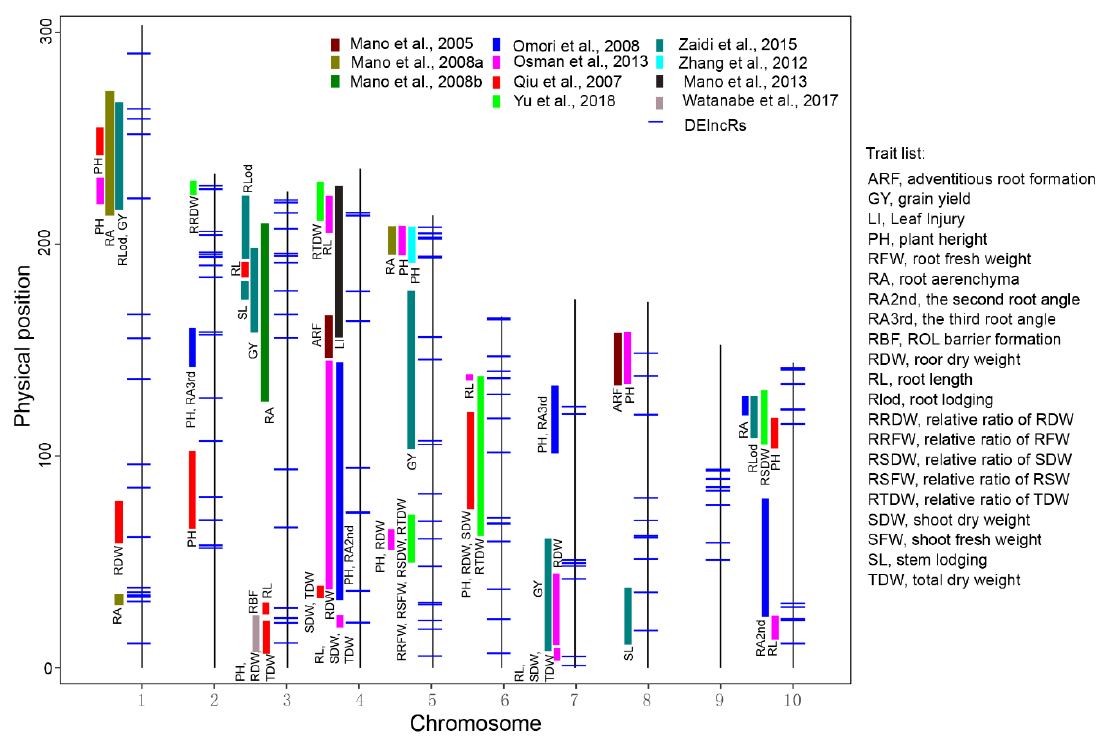
Figure 6. Co-localization of the differentially expressed long non-coding RNA (DElncRs) with previously identified quantitative trait loci (QTL) associated with waterlogging tolerance. The rectangular box represents the QTL interval, and the different colors indicate the different investigations.